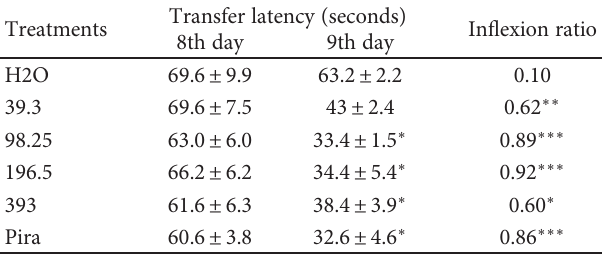
Table 1: E ff ect of M. inermis in normal mice in EPM. Treatments